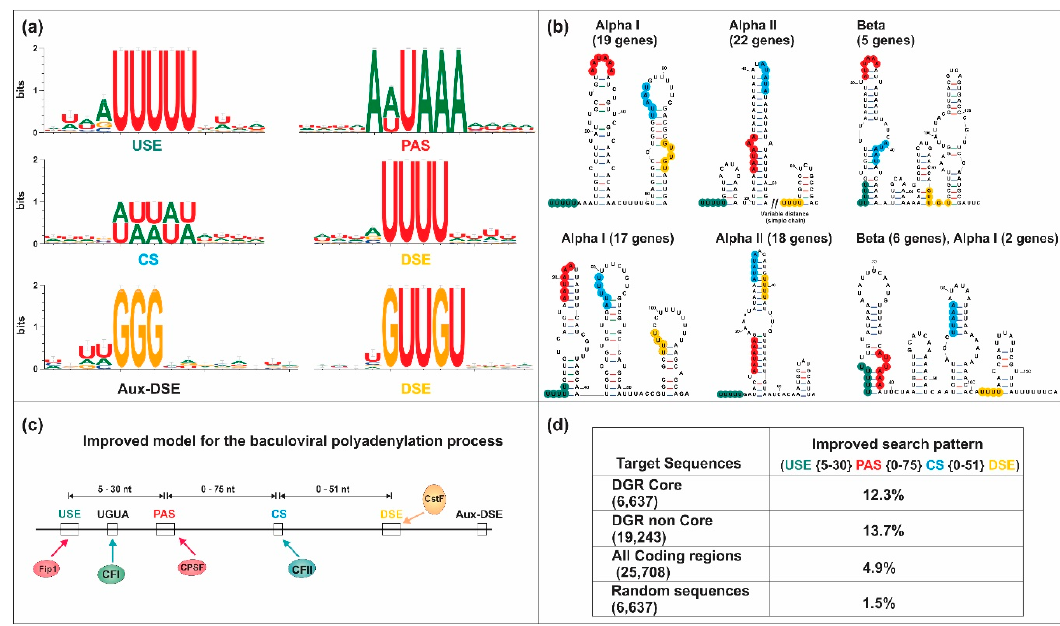
Figure 5. Comprehensive bioinformatic analysis of the 3 ′ end of baculoviral genes. ( a ) Sequence logos showing the nucleotide context of the main polyadenylation signals identified at DGR core genes. Each logo contains 237 sequences that correspond to DGR core genes in which the 6 motifs were detected (98 sequences from alphabaculoviruses Group I, 99 from alphabaculoviruses Group II and 37 from betabaculoviruses). PAS: Polyadenylation signal; USE: Upstream sequence element; DSE: Downstream sequence element; CS: Cleavage site: Aux-DSE: Auxiliary downstream sequence element. ( b ) Structural context of the polyadenylation signals. The secondary structure of the same sequences mentioned in ( a ) was determined and after a comparison, several conserved structures were detected; the 6 structures shown are the conserved ones adopted by most of the sequences used for the analysis. The number of genes in which the structures were identified is indicated in brackets. ( c ) Sequence elements involved in the polyadenylation mechanism in baculoviral genes. The positions of the elements involved and the ranges of distances between them are indicated, according to the improve model proposed in our working group. The different cellular factors that would be involved are also indicated. UGUA: motif that is eventually found upstream to the PAS and transcription end site; CPSF: Cleavage and specific polyadenylation factor; CstF: Cleavage stimulation factor; CFI and CFII: Cleavage factors I and II; Fip1: Pre-mRNA 3 ′ end-processing factor. ( d ) Detection of the improved model postulated in different data sets for validation. Searches were carried out on the DGR of core (DGR core) and non-core (DGR non core) genes, in addition to random sequences and all coding regions (nucleotides between the initial and stop codon) of all genes of genomes used. The amount of sequences in each data set is shown in brackets. The same colors are used in all panels: USE, green; PAS, red; CS: blue; DSE: yellow.